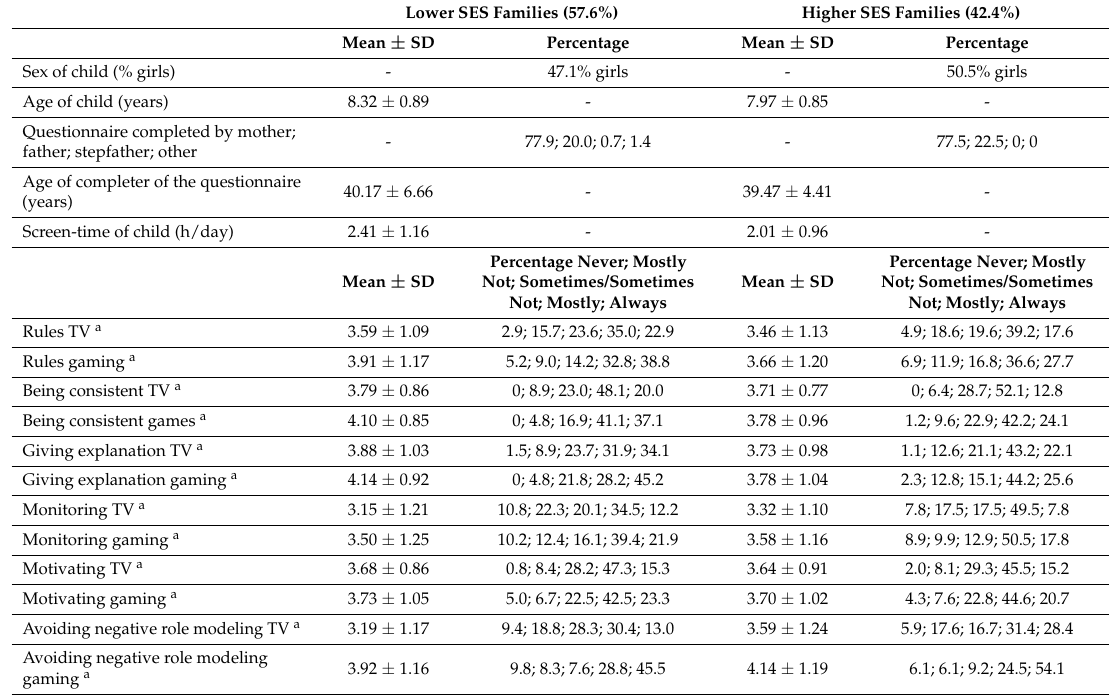
Table 2. Sample characteristics and descriptive statistics ( n = 247) for lower and higher SES families